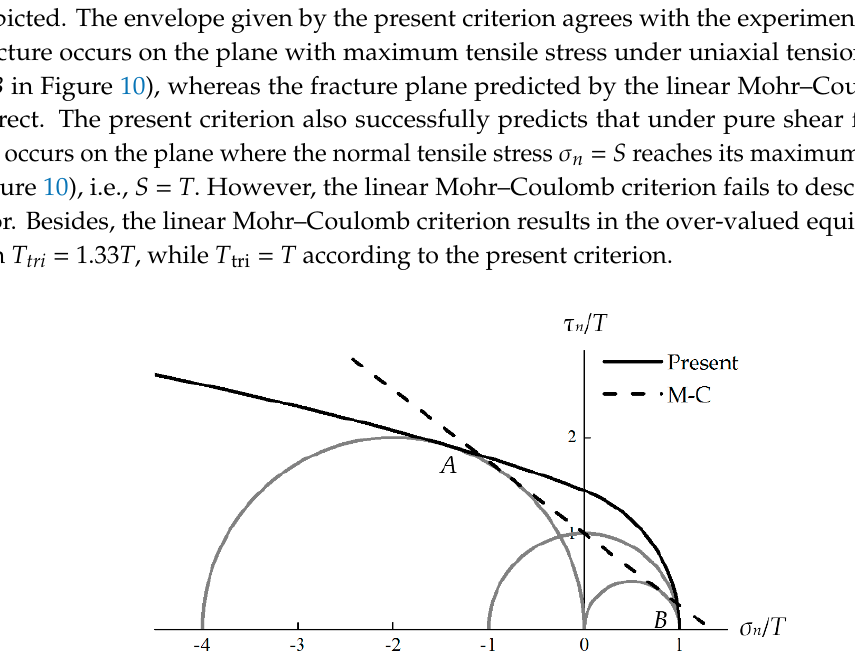
Figure 10. Failure envelopes and Mohr’s stress circles of cast iron. C / T = 4, θ T = 90.0°, and θ C = 37.0°.